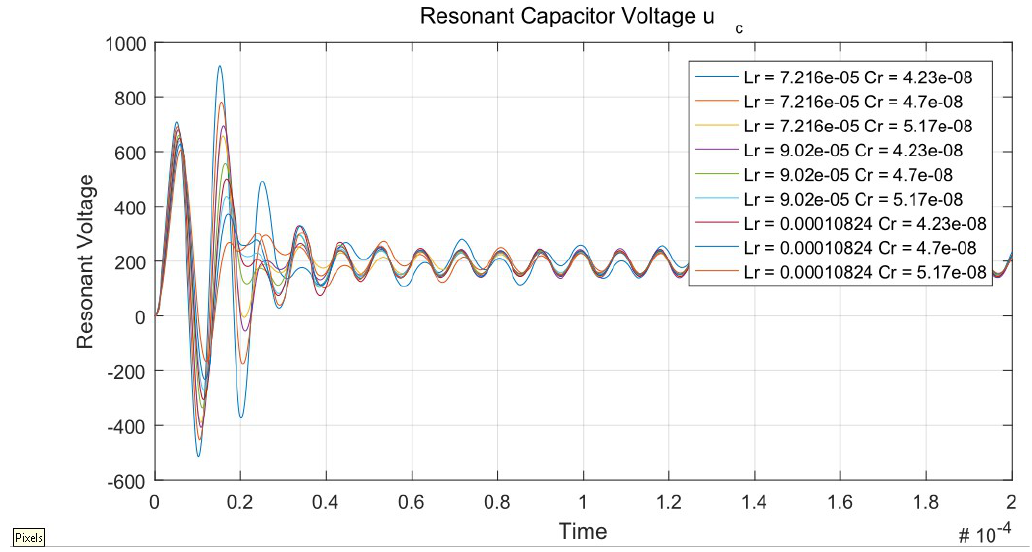
Figure 17. Tolerance analysis of the transient response of the resonant capacitor voltage with optimized values.